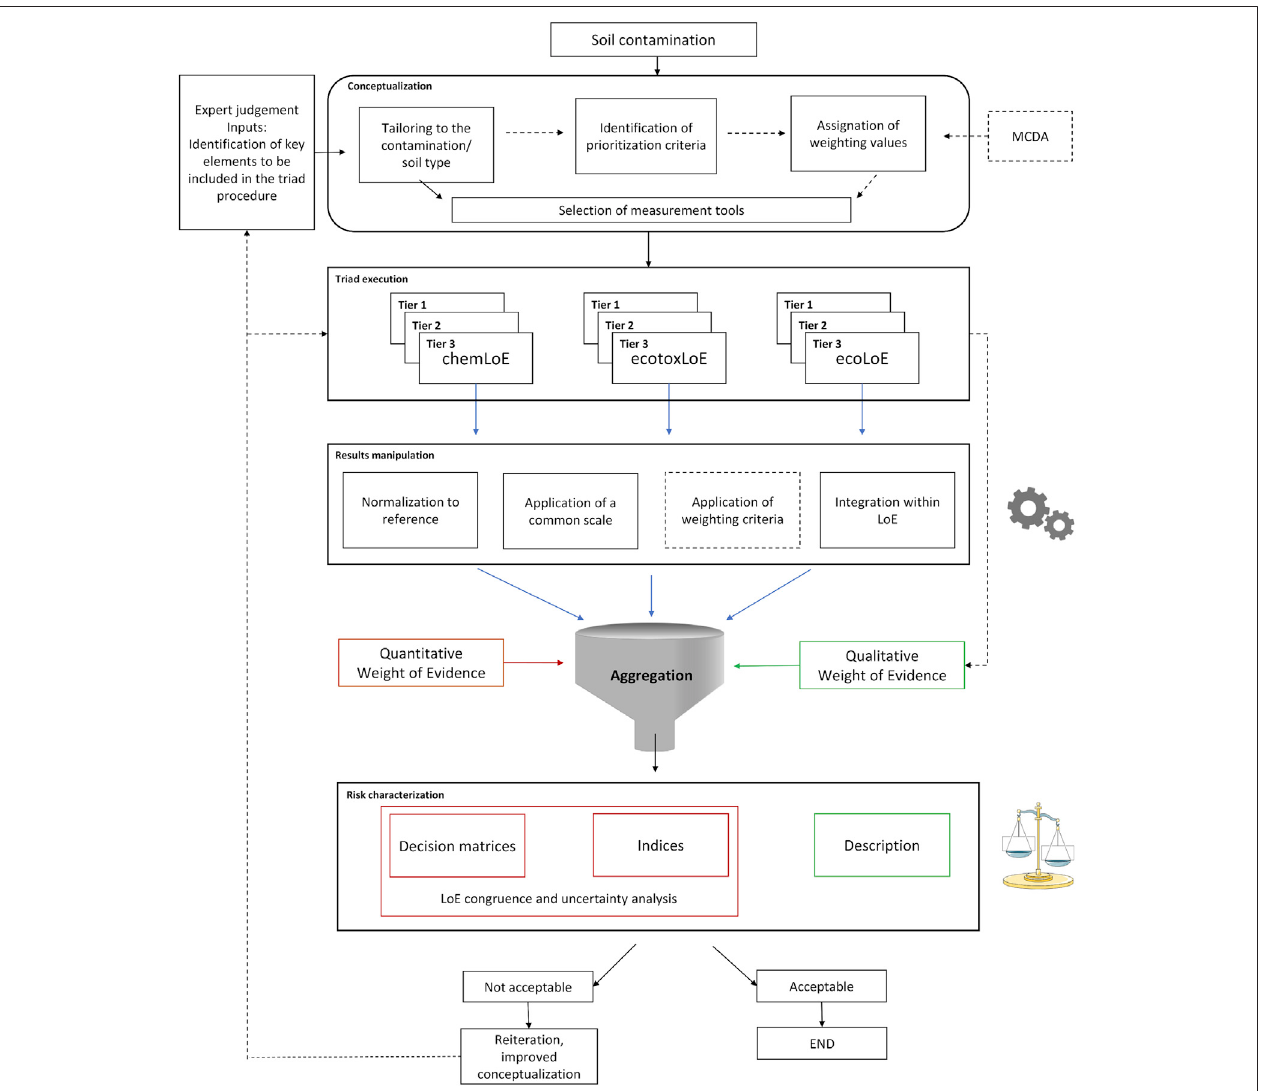
FIGURE 1 | Layout of the main steps involved in the triad procedure, from the problem formulation, to execution and integration phases. Solid lines represent the minimal work fl ow composing the triad approach. Dashed lines symbolize additional steps that can integrate the different parts of the procedure.